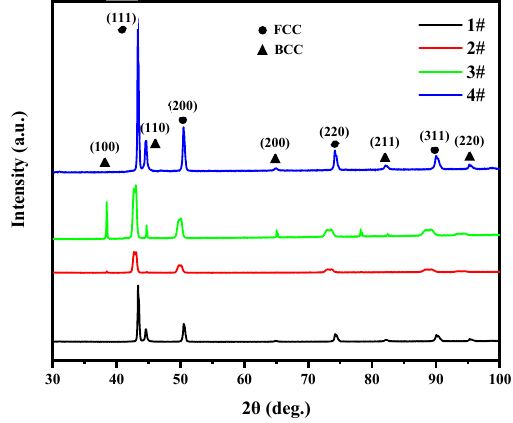
Figure 3. The XRD results of four different high entropy alloy powders.